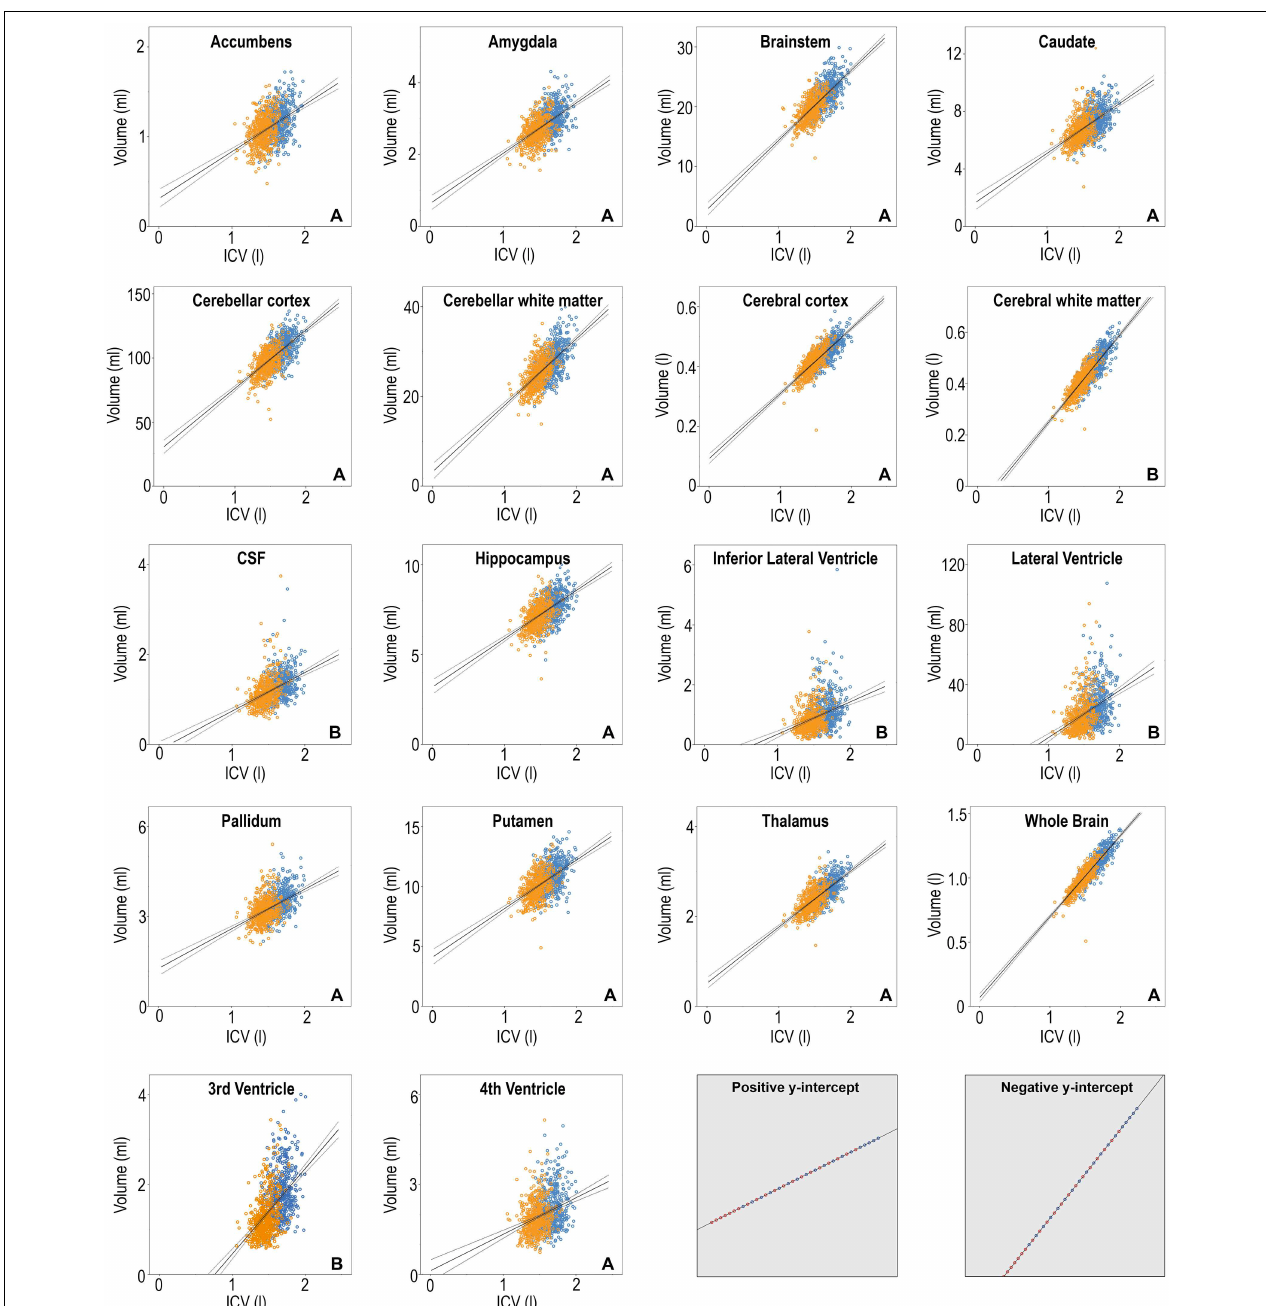
indicates whether the y-intercept in the regression line is positive or negative. The two gray squares in the lower right corner involve imaginary data. In these cases, a sex difference is clearly not present. The proportions method would however show significant effect of sex because the regression line does not have zero